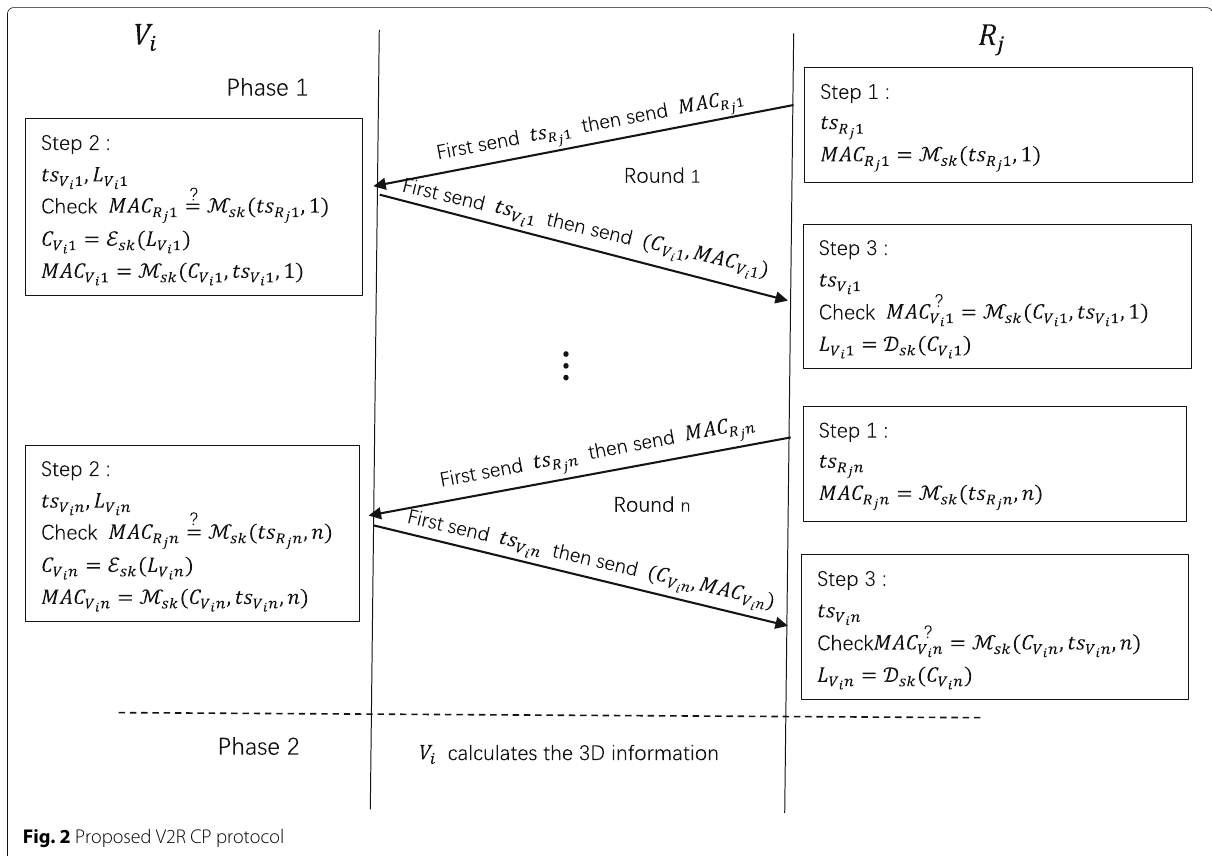
period of time (cid:4) t . We will show how to choose (cid:4) t in our